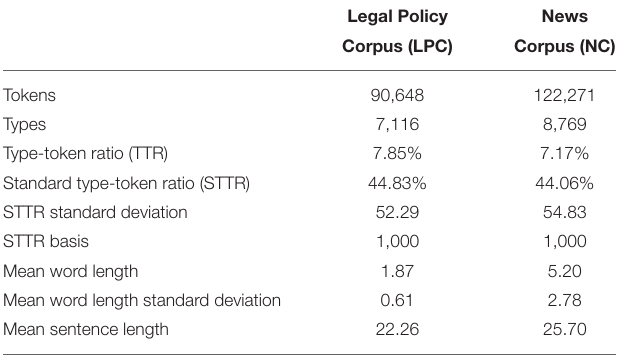
TABLE 2 | Basic features of the two corpora. TABLE 3 | Word length distribution of legal policy corpus (LPC) and news corpus